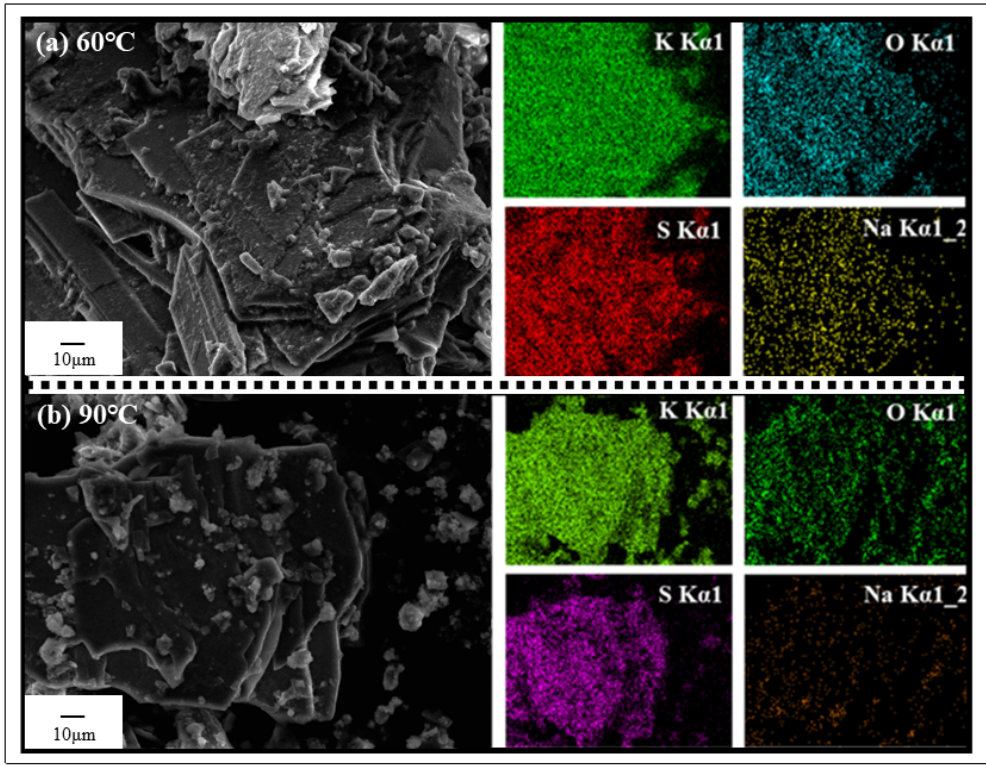
Figure 11. Electron microscopy and energy spectrum of crystal production after leaching at ( a ) 60 °C and ( b ) 90 °C.